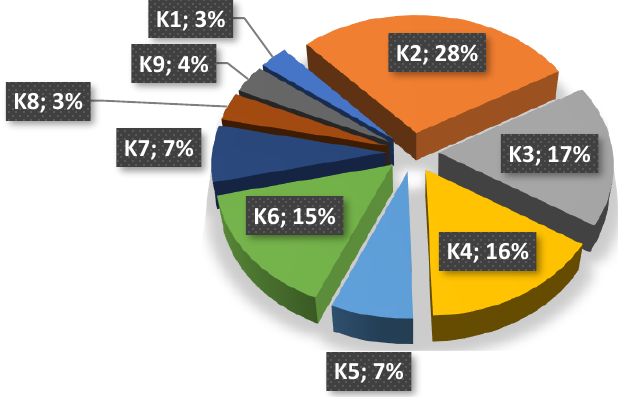
Figure 6. Weighted criteria expressed as percentages, according to Expert 3.